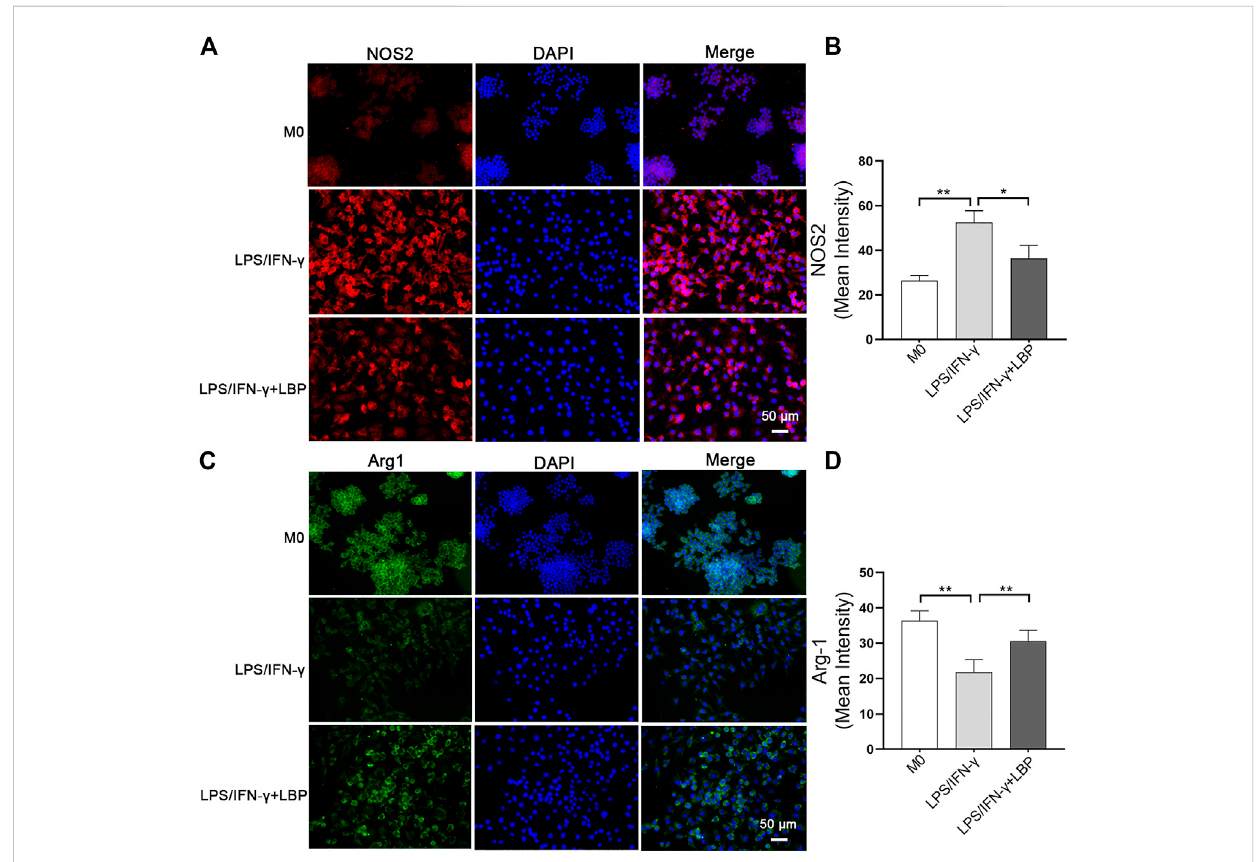
FIGURE 4 Thein fl uenceofLBPontheexpressionofNOS2andArg-1inRAW264.7cellswasinvestigatedbyimmunostaining. (A) Immuno fl uorescencestaining of NOS2 (red) in different groups. (B) The quanti fi cation of the mean fl uorescence intensity of NOS2 in Figure 4A. (C) Immuno fl uorescence staining of Arg-1 (green) in different groups. (D) The quanti fi cation of the mean fl uorescence intensity of Arg-1 in Figure 4C. Signi fi cant differences are indicated as * p < 0.05, ** p <